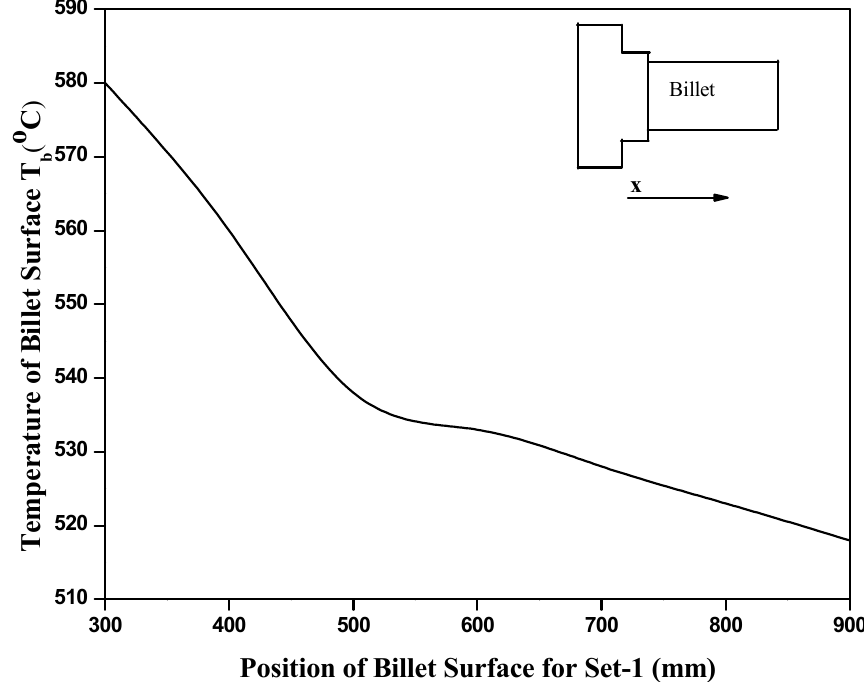
Figure 7. Variation in surface temperature of billet for the length of one absorber plate.